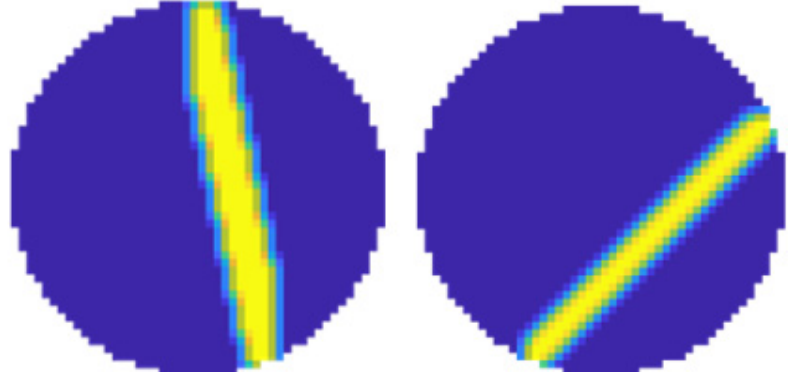
Figure 14. Example sensitivity